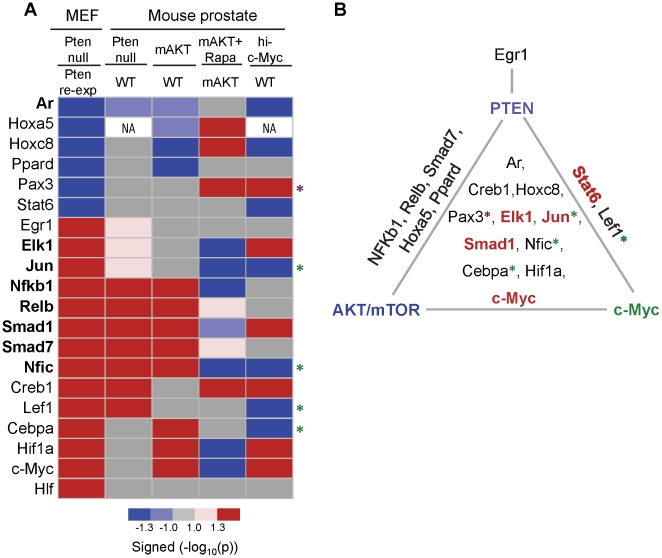
PTEN-regulated TFAs are significantly increased in murine prostate cancer models in vivo.(A) Heatmap showing changes of PTEN-regulated TFAs in PTEN inducible MEFs (PTEN null compared to PTEN re-expression or PTEN WT) and murine prostate cancer models (compared to WT control mice; Rapa: Rapamycin treatment). TFAs regulated by PTEN/AKT/mTOR pathway are marked in bold. TFAs exhibit discordant regulation between c-Myc and the PTEN/AKT/mTOR pathway are marked by *. The purple and green asterisks indicate Myc-activating and suppressing TFs respectively. (B) Triangle diagram summarizing the TFAs regulated by PTEN, AKT/mTOR and/or c-MYC.